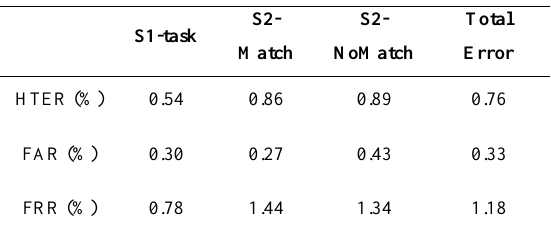
Table 1. Mean error for tasks for all individuals of the 18- channel system.